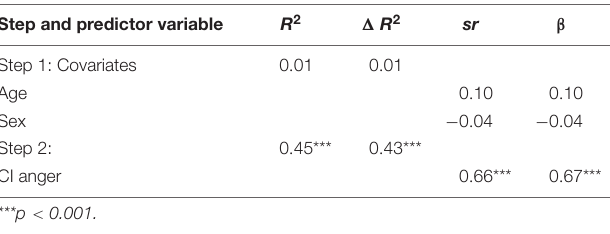
TABLE 2 | Hierarchical multiple regression on the prediction of externalizing behavior by CI anger.